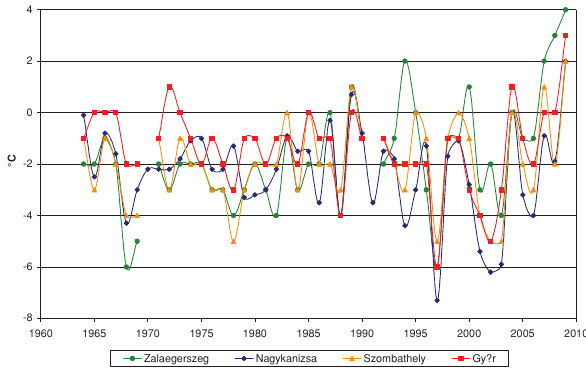
Figure 1. Absolute minimum temperatures in April